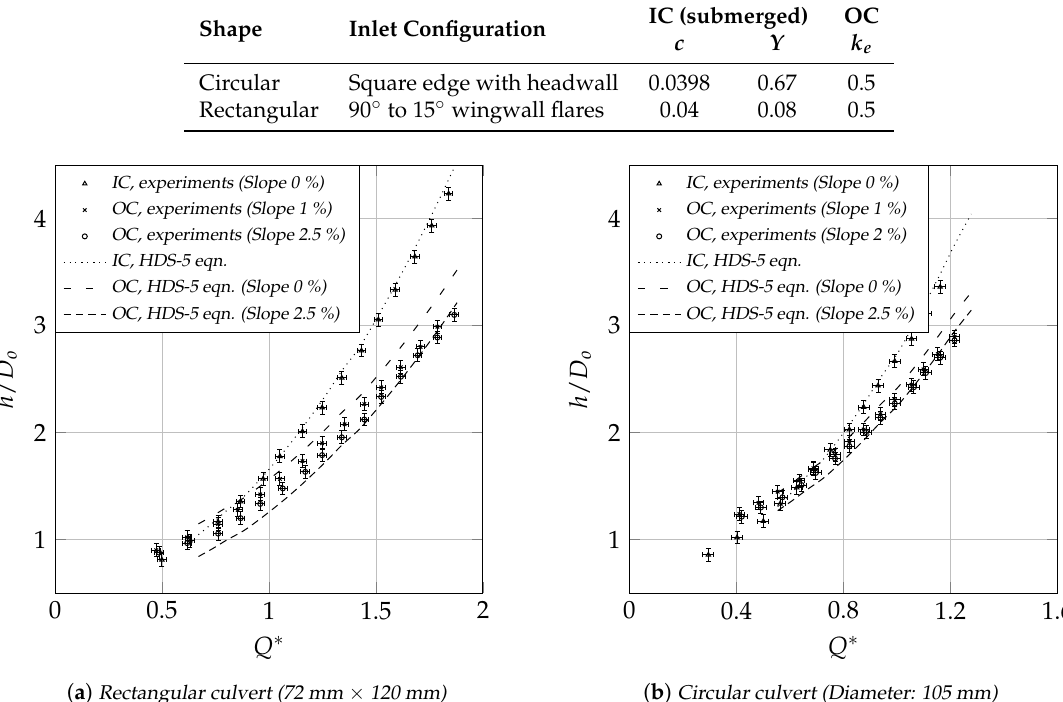
Figure 1. Experimental and calculated test results with a total pipe length of 700mm. Max. error flow meter: 1%; max. error piezometer: 2mm; n =